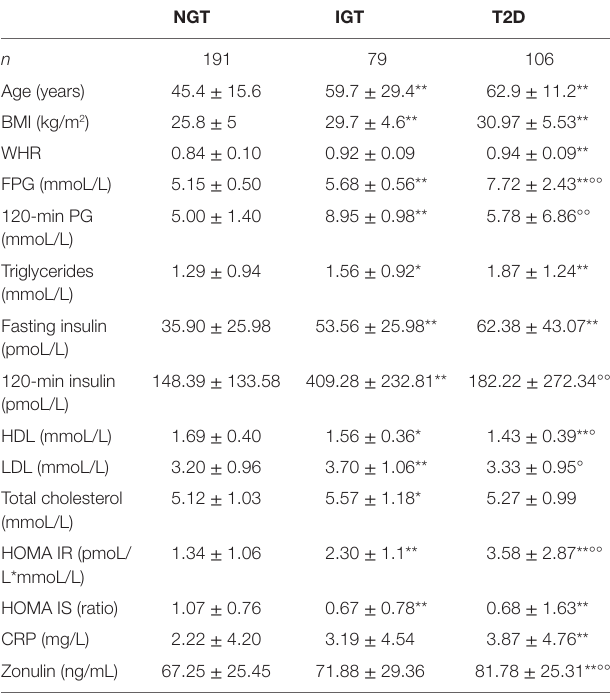
TaBle 2 | Main characteristics of the study participants.